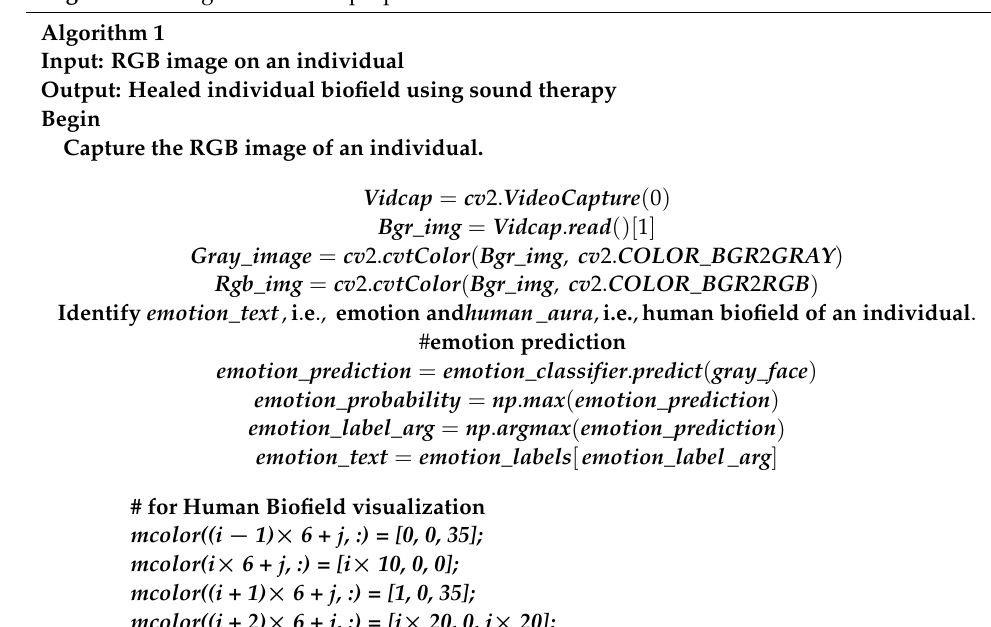
Algorithm 1: Algorithm of the proposed method. Algorithm